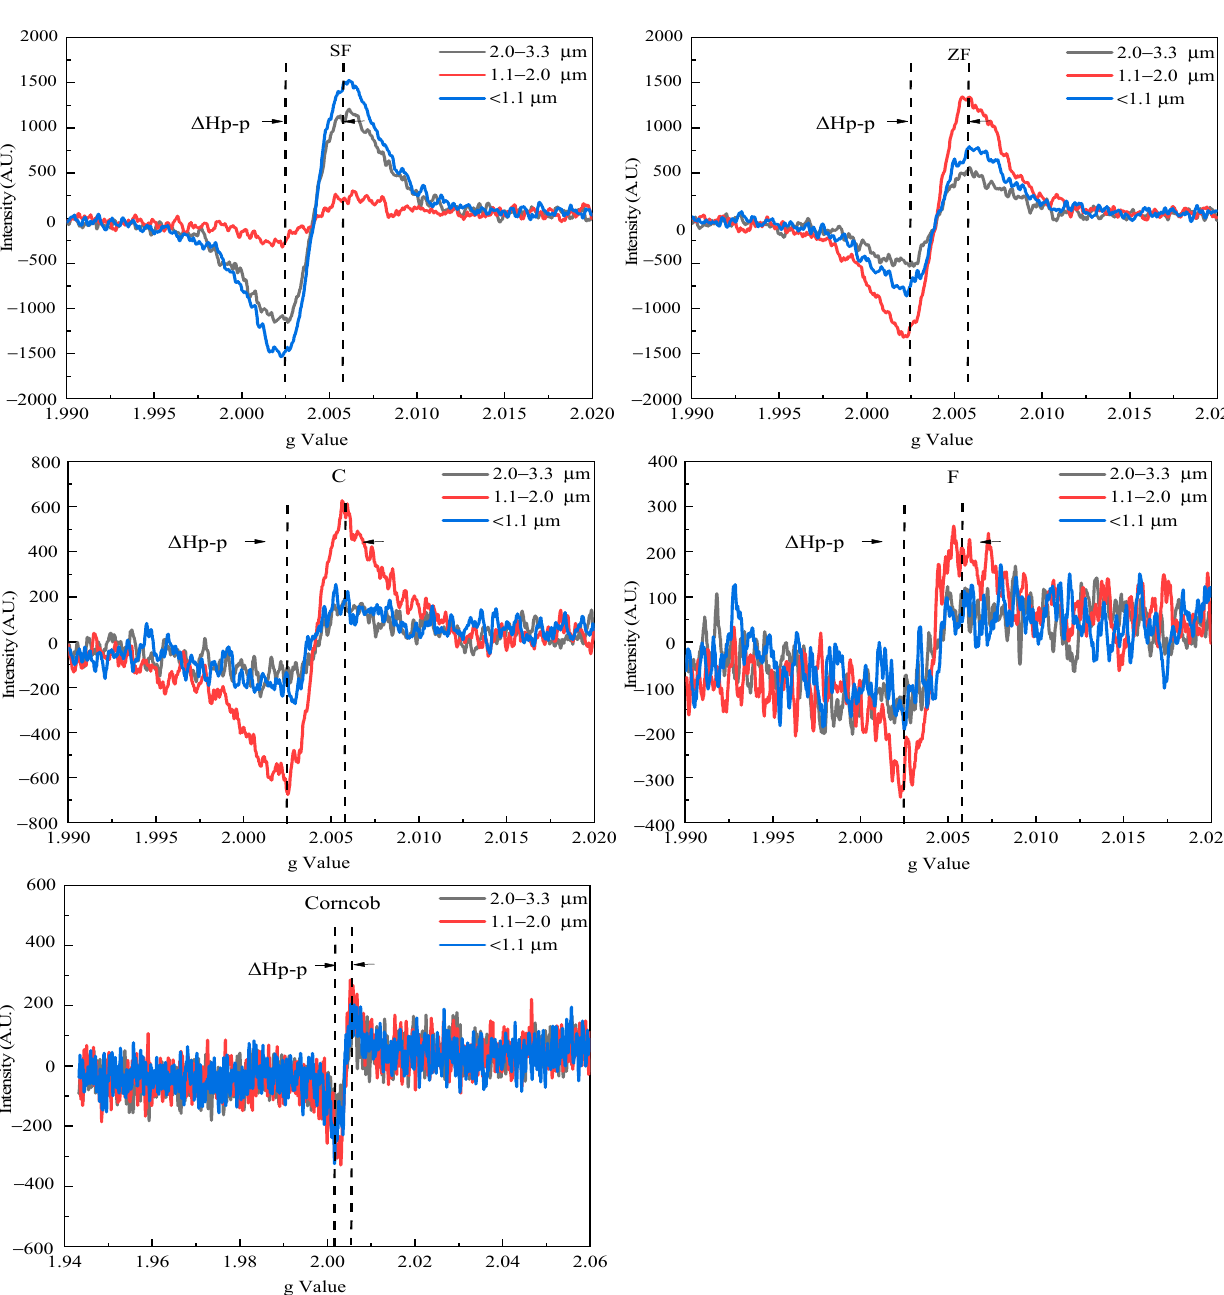
Figure 4. The mean g factor and Δ Hp-p of the EPFRs.